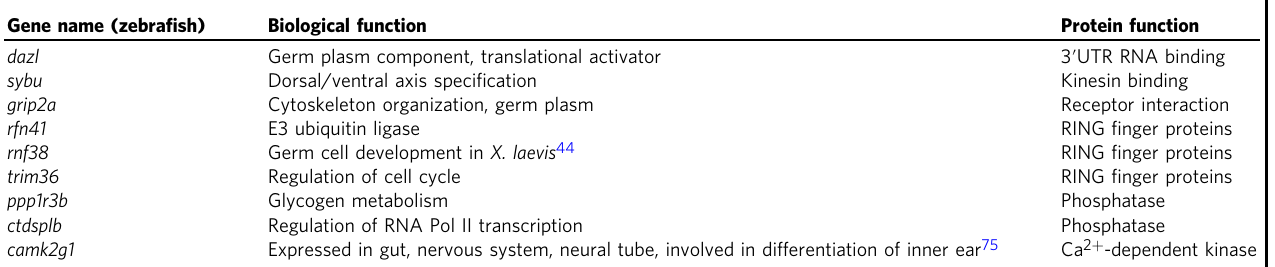
Table 1 Vegetally localized genes in zebra fi sh, X. laevis and X.tropicalis . Gene name (zebra fi